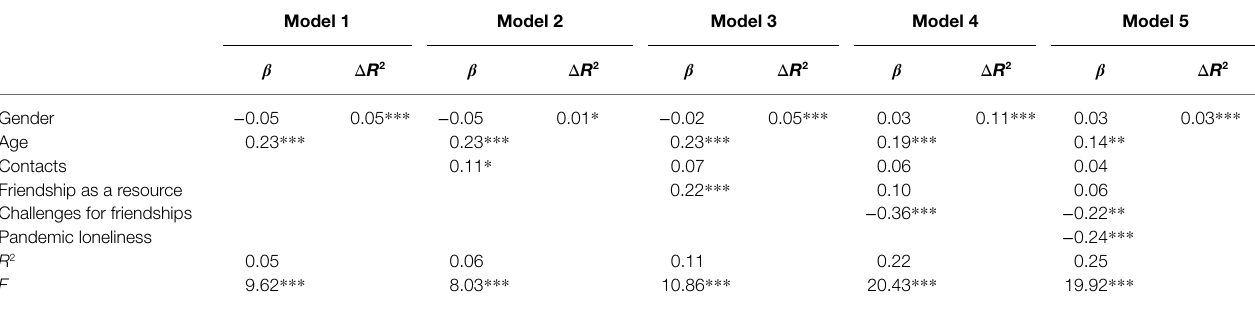
TABLE 3 | Regression analysis to predict